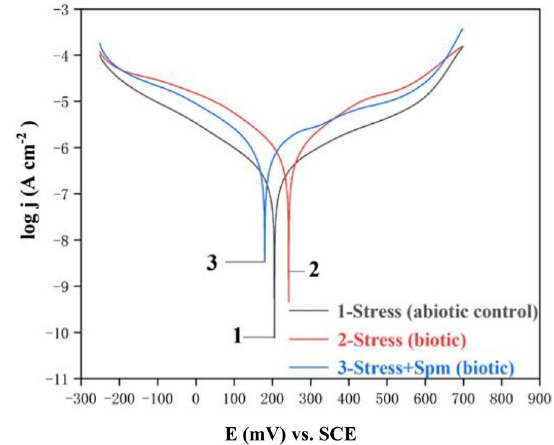
Fig. 7 Tafel polarization curves of pyrite working electrode with and without biofilm coverage 7 days after Li + /Co2 + addition to simulate metal ion stress in bioleaching [Liu et al.